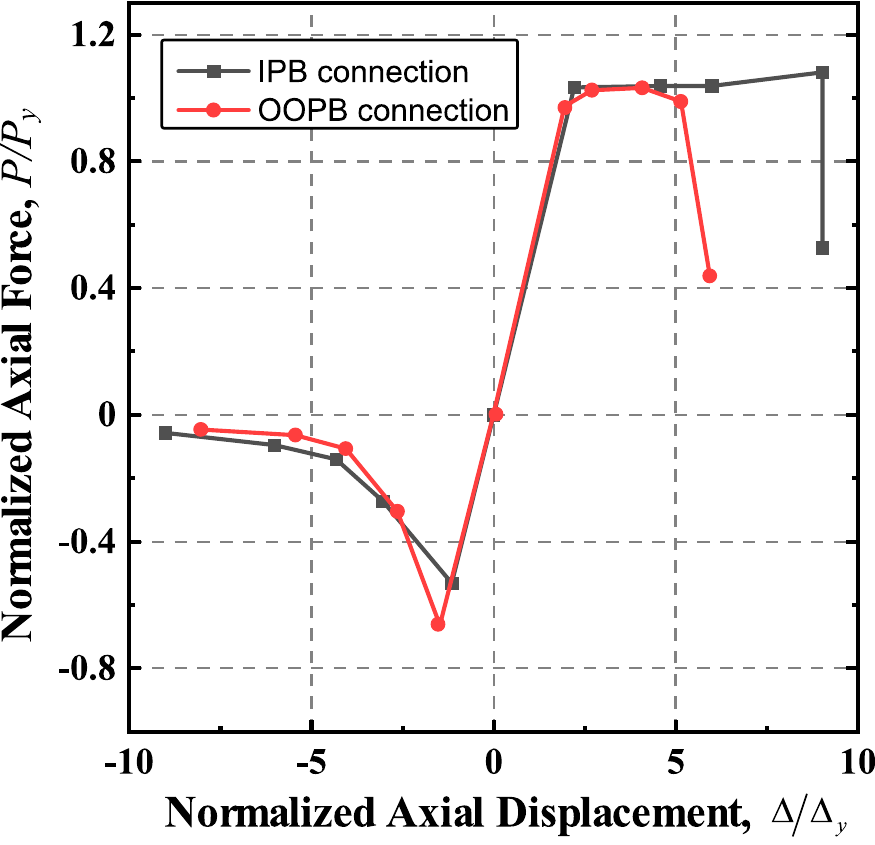
Figure 10. Comparison of the backbone curve of the IPB and OOPB connection braced system. Table 3. Observation of various damage states of the IPB Braced system.